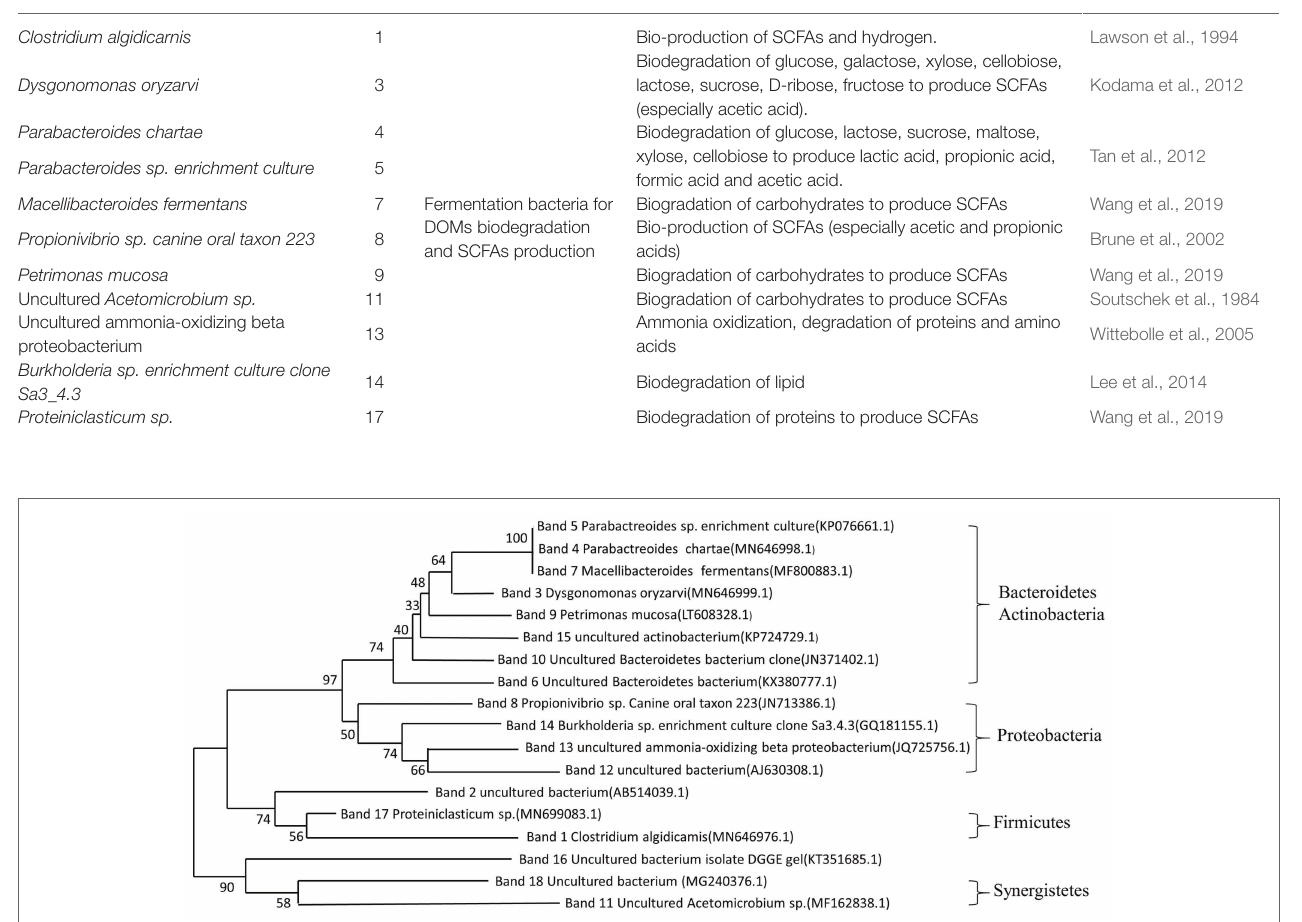
FIGURE 4 | Neighbor-joining tree for phylogenetic identities of the bacteria in DGGE